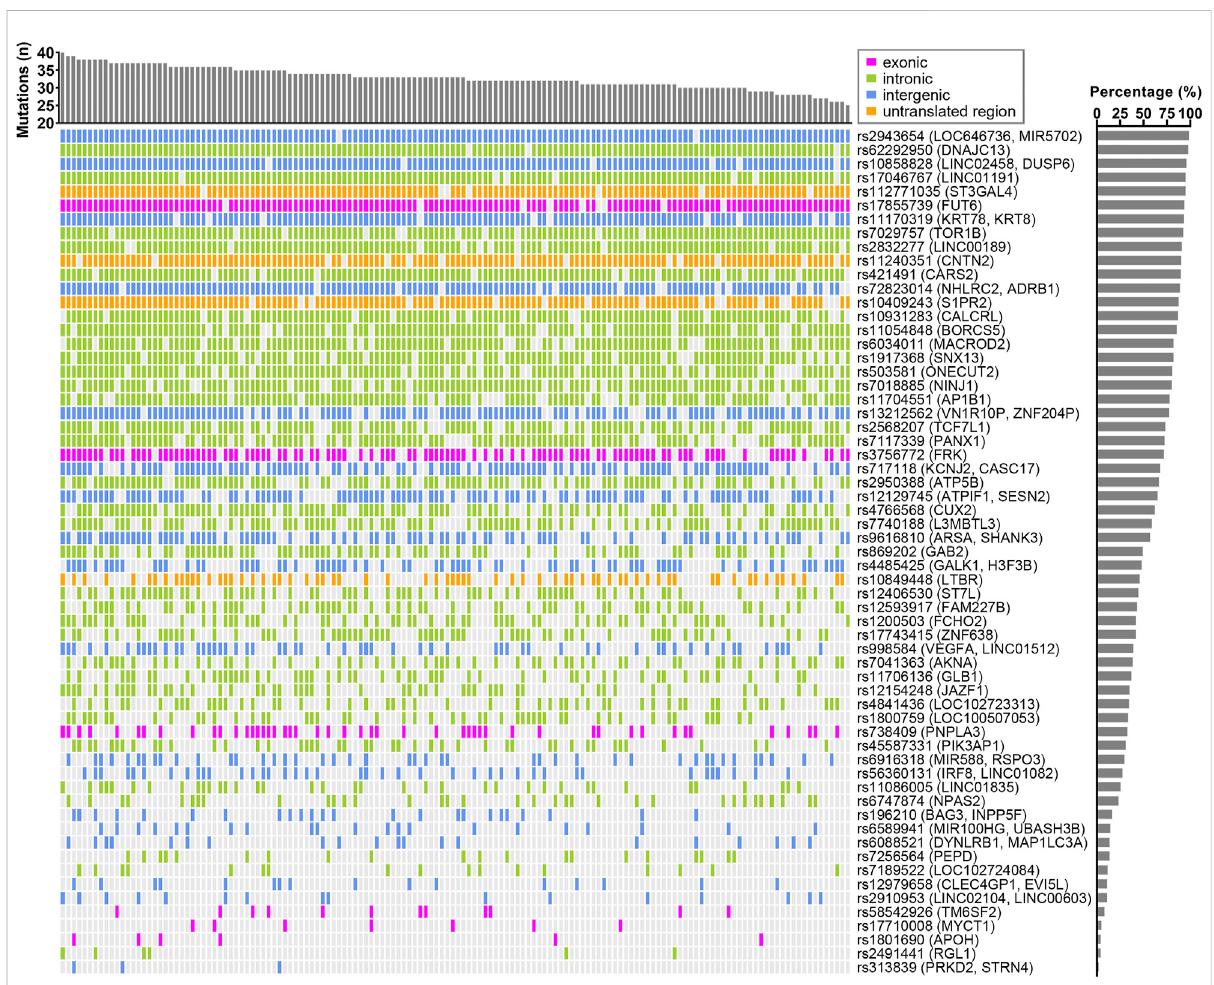
FIGURE 1 Landscape of AST-associated variants in CCHC subjects with elevated AST. The bar chart at the top represents the number of variants in each subject.ThebarchartontherightshowsthefrequencyofeachvariantinthoseCCHCsubjectswithelevatedASTlevels.Eachcolumnrepresentsone subject and each row represents one